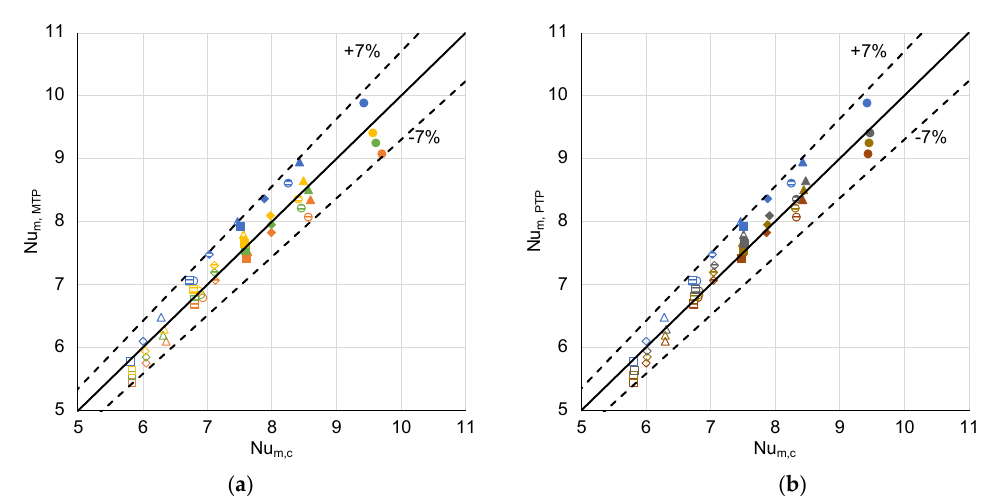
Figure 10. Validation of Nu (cid:2923),(cid:2913) correlation for ( a ) MTP and ( b ) PTP.